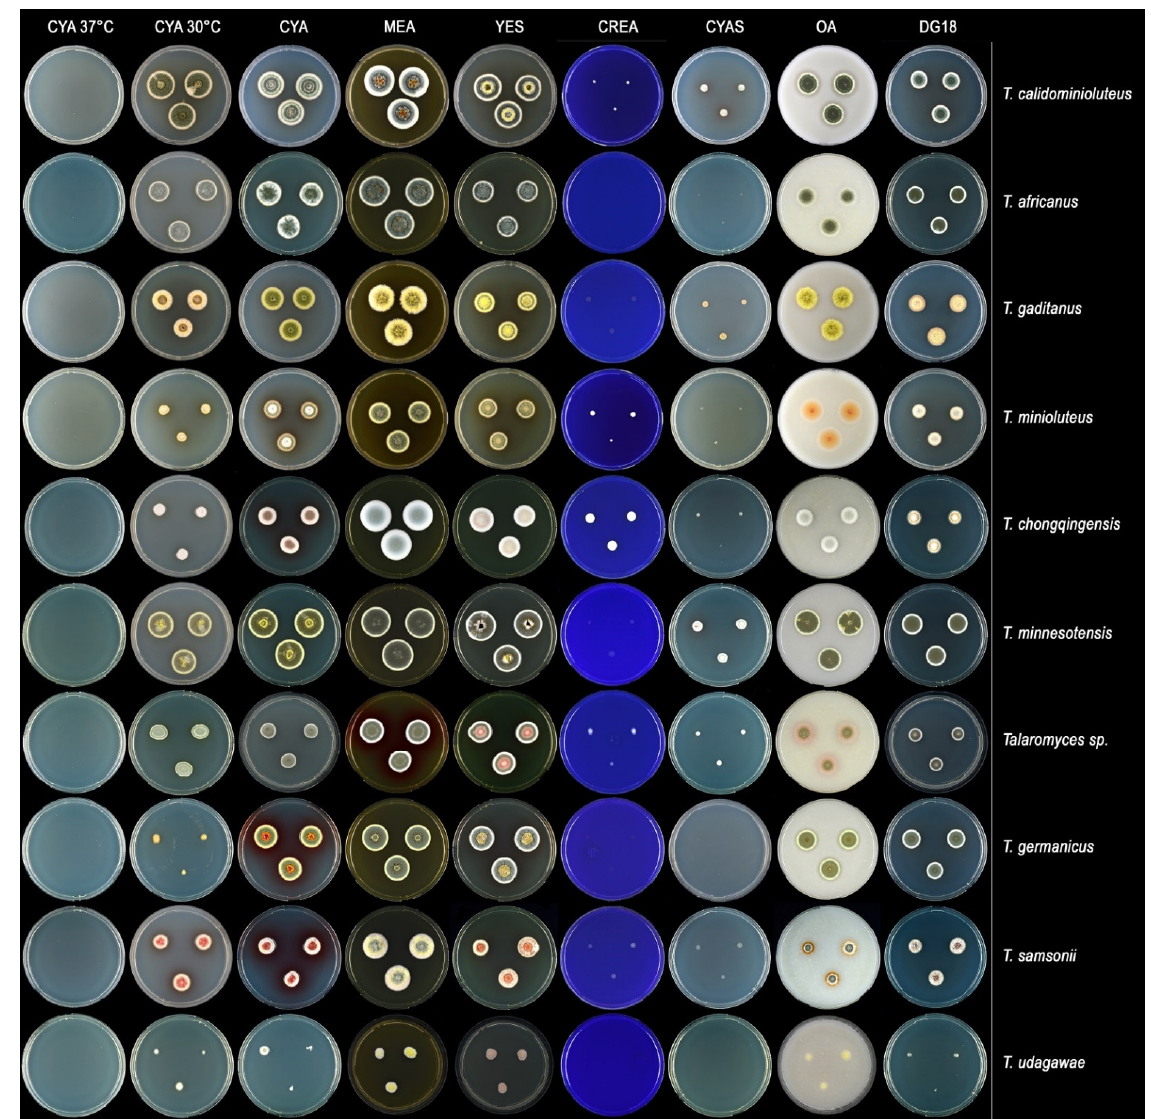
Figure 4. Left to right: 7 d old colonies on CYA 37 °C, CYA 30 °C, CYA, MEA, YES, CREA, CYAS, OA, DG18; from top to bottom: T. calidominioluteus (DTO 390-E9), T. africanus (CBS 147340), T. gaditanus (CBS 169.81), T. minioluteus (CBS 642.68), T. chongqingensis (CBS 147316), T. minnesotensis (CBS 141838), Talaromyces sp. (CBS 147336), T. germanicus (CBS 147314), T. samsonii (CBS 137.84), T. udagawae (CBS 579.72).